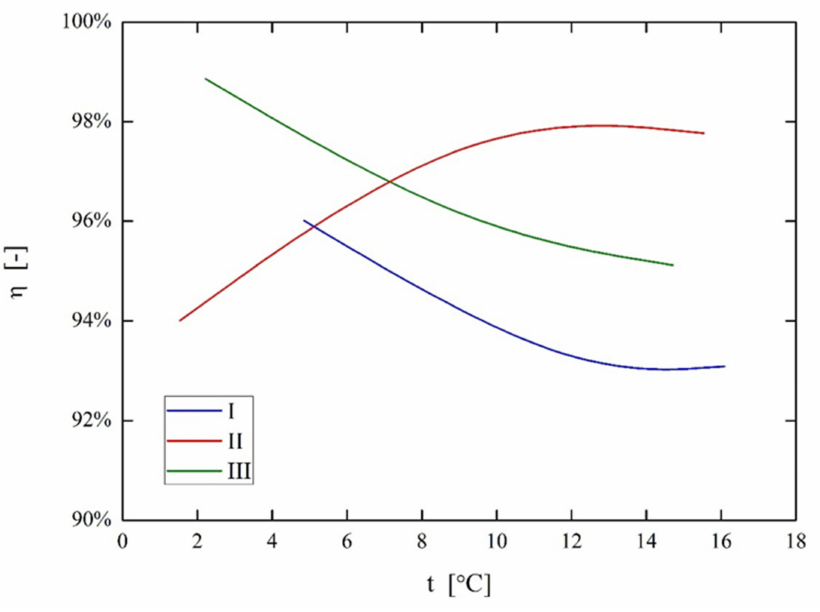
Figure 23. HEX efficiency η versus the fresh air temperature at the inlet to HEX for different volumetric flow